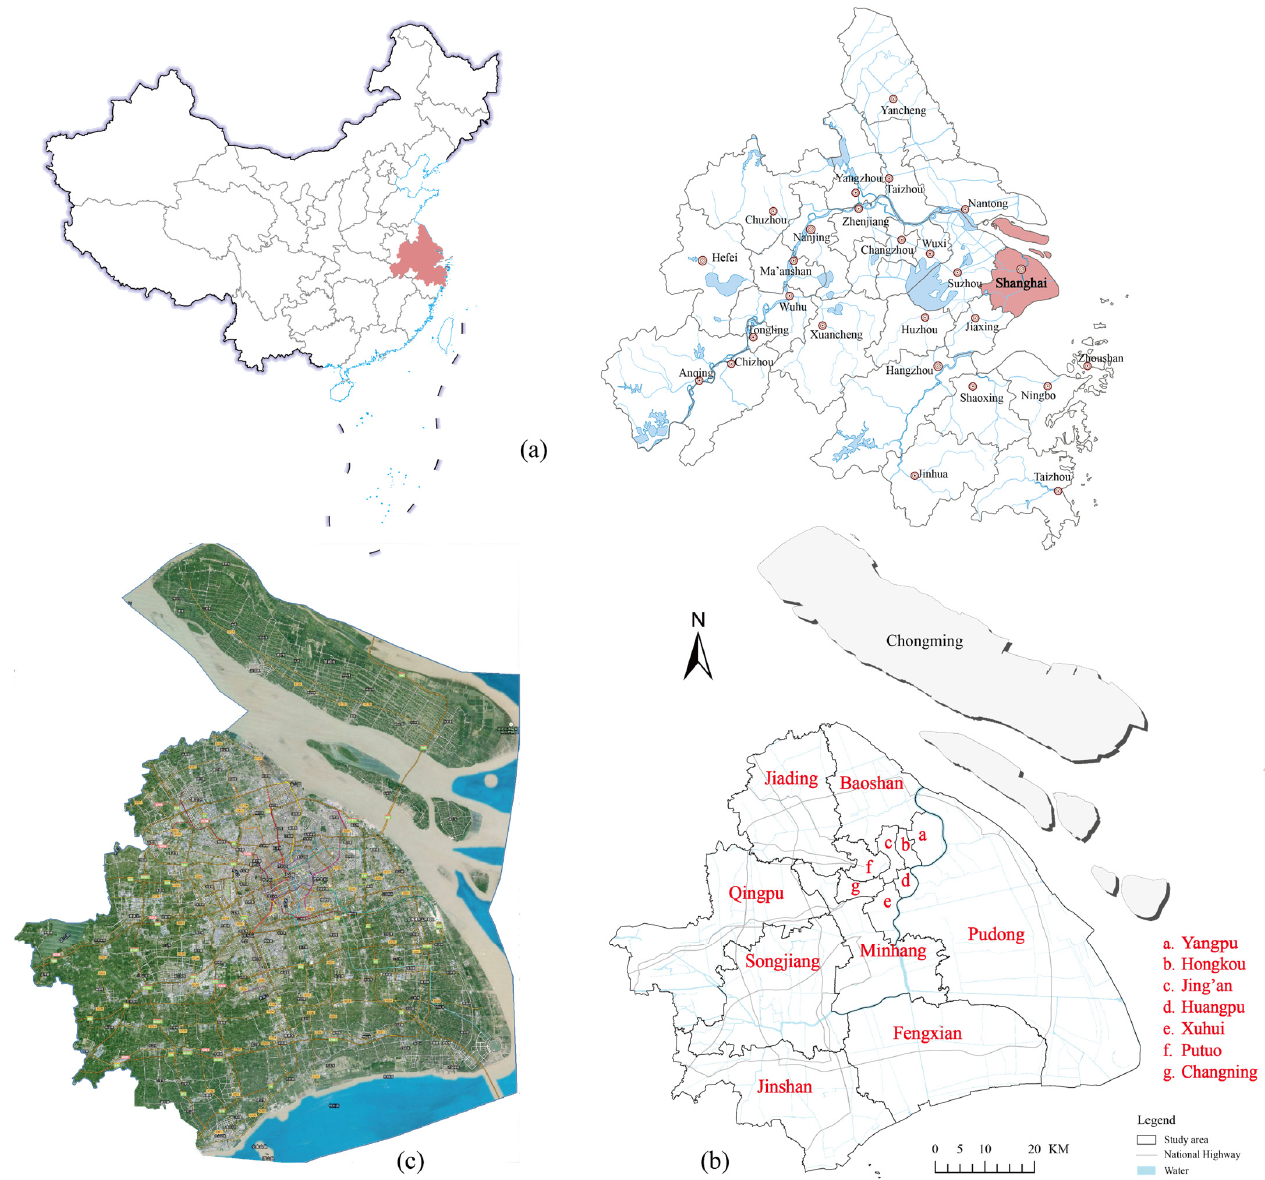
Figure 1. Location of the study area ( a ), the administrative division ( b ) and the areal imagery in 2020 ( c ). Shanghai is close to the estuary of the Yangtze River and is a plain densely covered with rivers. In addition, Shanghai has a highly developed transportation system, which jointly leads to fragmented landscapes. Shanghai has approximately 6833 square